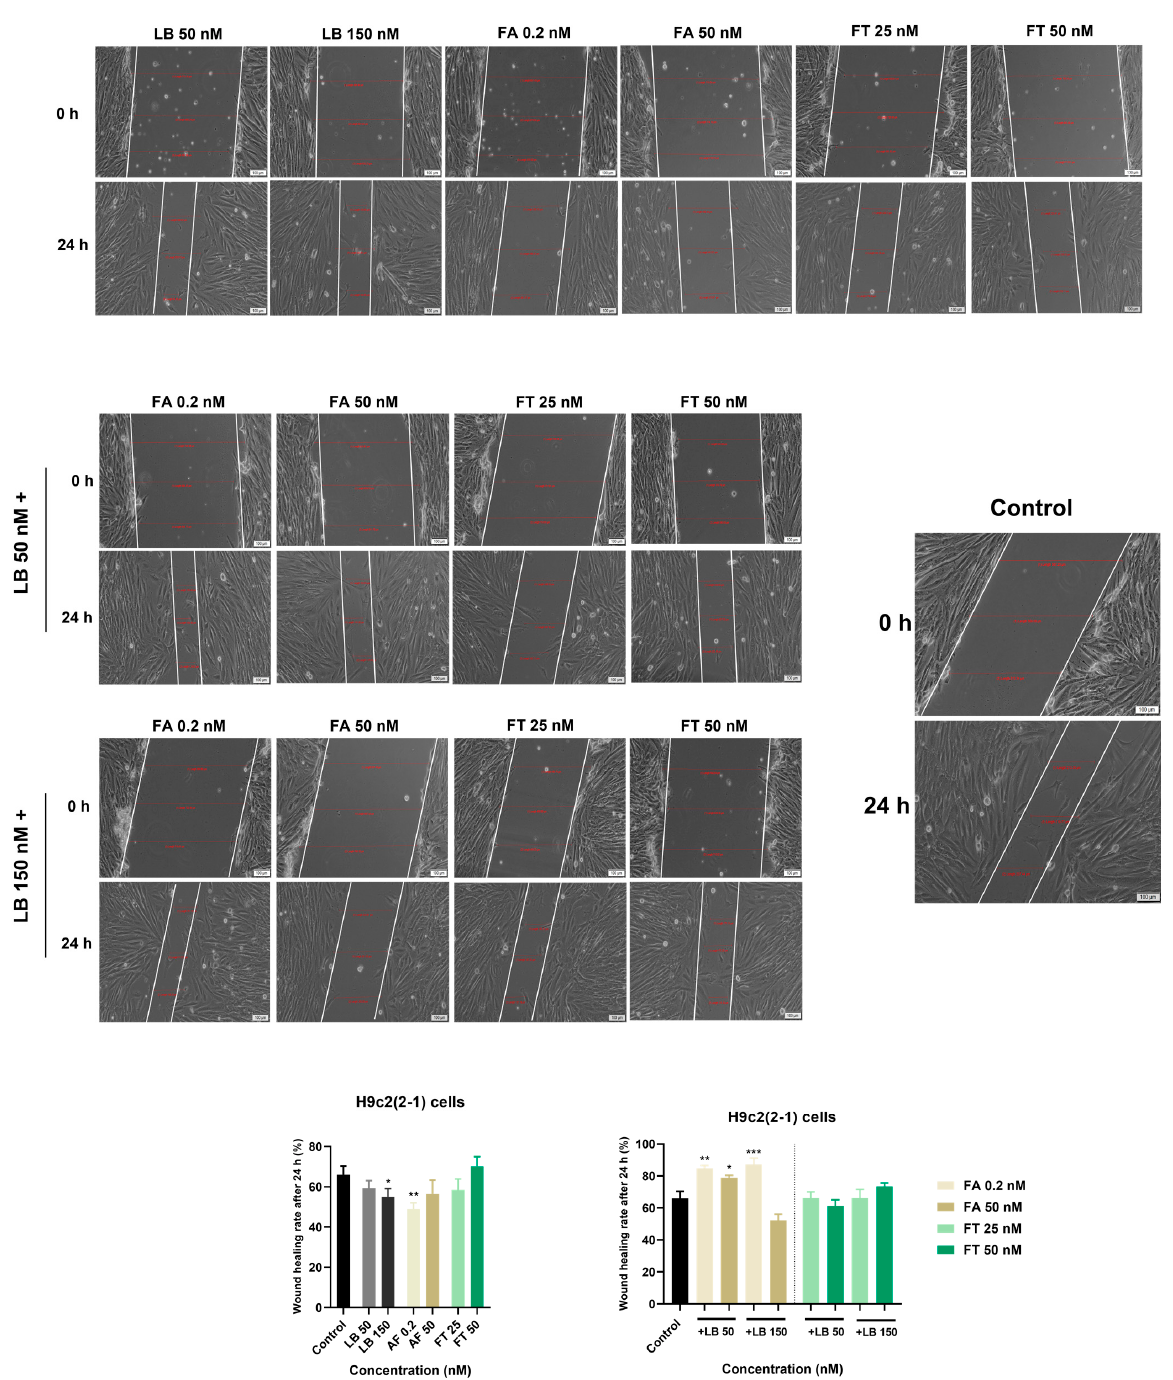
Figure 5. Representative images highlighting the impact of LB, FA, FT, and their combinations on wound regeneration in H9c2(2-1) cells following a 24 h treatment, and graphic representations of the calculated wound healing rates for each treatment regimen (single and combined). The white lines indicate the wound area. The scale bars indicate 100 µ m. The data are expressed as the mean values ± SD of three independent experiments performed in triplicate. The statistical differences between the control and the treated group were quantified by one-way ANOVA analysis followed by Dunnett’s multiple comparisons post-test (* p < 0.05; ** p < 0.01; *** p <